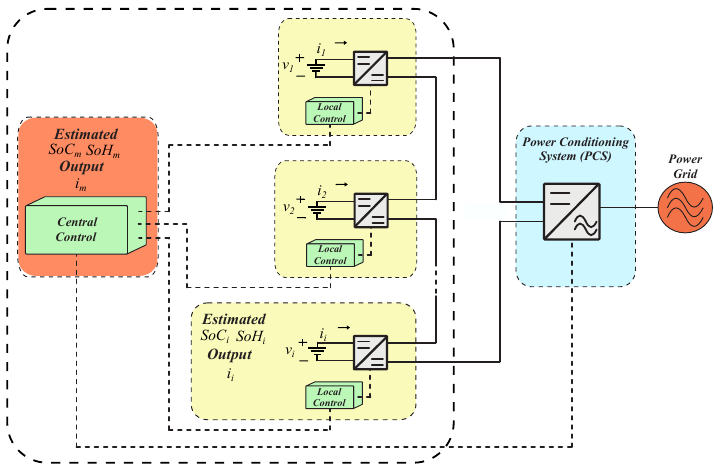
Figure 5. Charger Topology based on a coordinated decentralized control